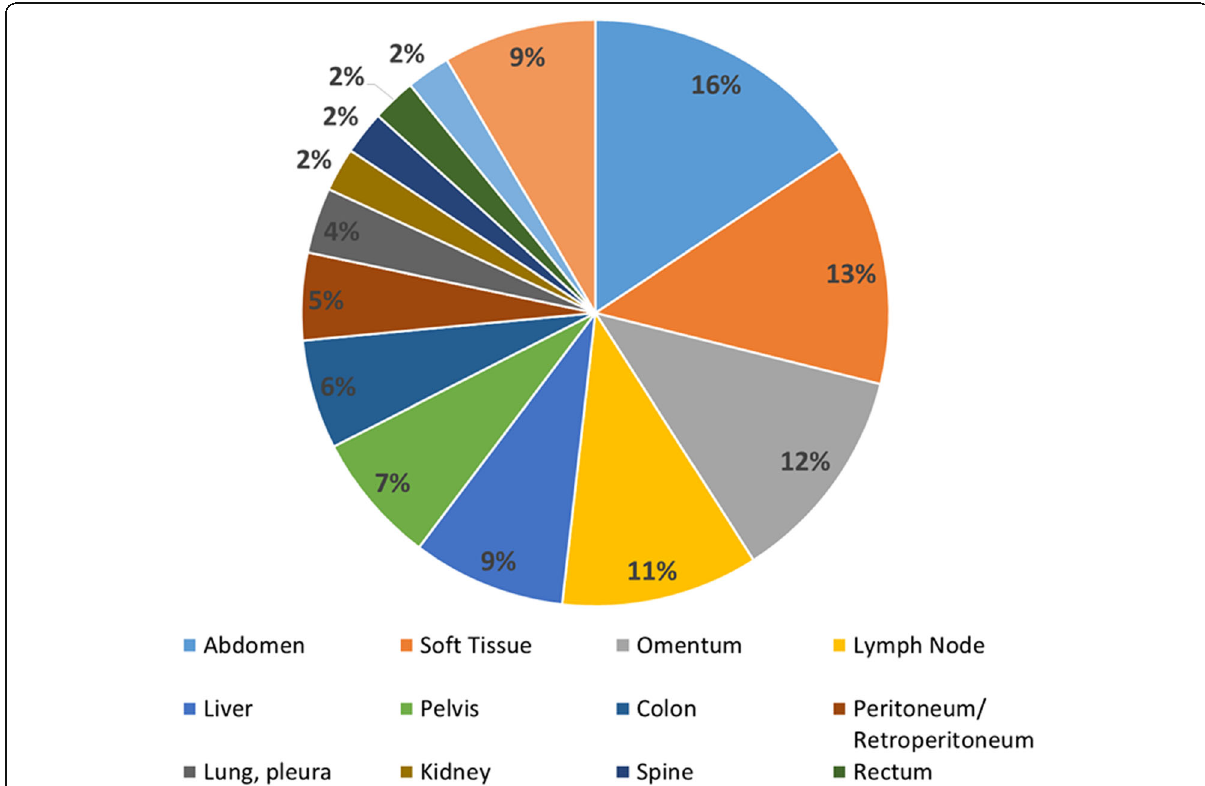
Fig. 1 Distribution of specimen sites. Distribution of DSRCT specimen sites sent to Foundation Medicine, Inc. for Comprehensive Genomic Profiling